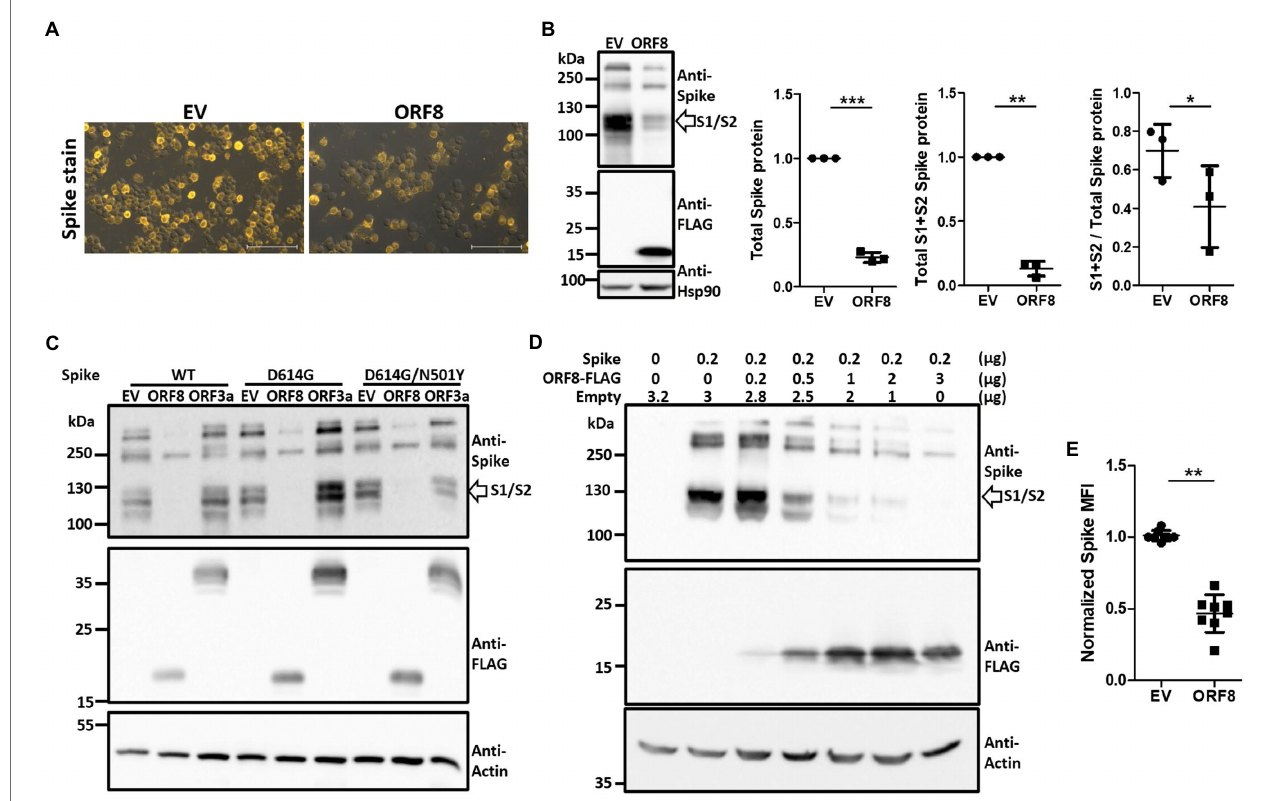
FIGURE 2 | Expression of ORF8 shows the downregulation and insufficient S1/S2 processing of the spike protein in a dose-dependent manner. (A) Spike protein immunostaining of Spike pseudovirus-packaging cells was performed. One representative result is shown, and the yellow color indicates the spike signal. EV: empty vector. (B) Immunoblots of Spike pseudovirus-packaging cells were obtained with antibodies specific to the spike protein and FLAG tag to visualize the protein level of the spike protein and ORF8. An antibody specific to Hsp90 served as a loading control. The scatter plot shows the relative intensity of the signals quantified by the ImageJ software from three independent experiments. The cleaved S1 and S2 fragments (between 100 to 130 kDa) were selected and determined as “S1 + S2 spike protein” and all fragments visualized above 100 kDa (containing the cleaved S1/S2 fragments and the full-length spike protein) were all selected and evaluated as “total spike protein” for quantification in this figure. In order to visualize the spike signal in ORF8-transfected samples together with EV-transfected samples in the same blot, the intensity of S1/S2 fragment of EV-transfected might reach plateau level then the real intensity might be underestimated. So the true efficiency of S1/S2 cleavage in EV-transfected cells might be much higher than the data shown here. (C) Immunoblots of cells transfected with ORF8 or ORF3a in combination with different spike variants. Here, an antibody specific to the FLAG tag indicates the protein levels of ORF8 and ORF3a. WT: Spike obtained from the original Wuhan strain; D614G: WT spike protein with the D614G mutation; D614G/N501Y: WT spike protein with the D614G and N501Y mutations. (D) Immunoblots of HEK293T cells transfected with different amounts of ORF8-expressing plasmids were obtained 3 days post-transfection. Here, an antibody against actin served as the loading control. Empty: empty vector does not encode ORF8. (E) FACs analyses of surface spike protein were performed using HEK293T cells cotransfected with spike-encoding plasmid together with pLAS2-based plasmid carrying ORF8 or empty vector at 1–9 ratio at 3 days post-transfection. The data are shown as the means ± SDs (error bars). Here, the paired Student’s t -test was used, and p < 0.05 indicates a statistically significant difference; * p < 0.05, ** p < 0.01, *** p < 0.001. The scale bar in each figure represents 100 μ